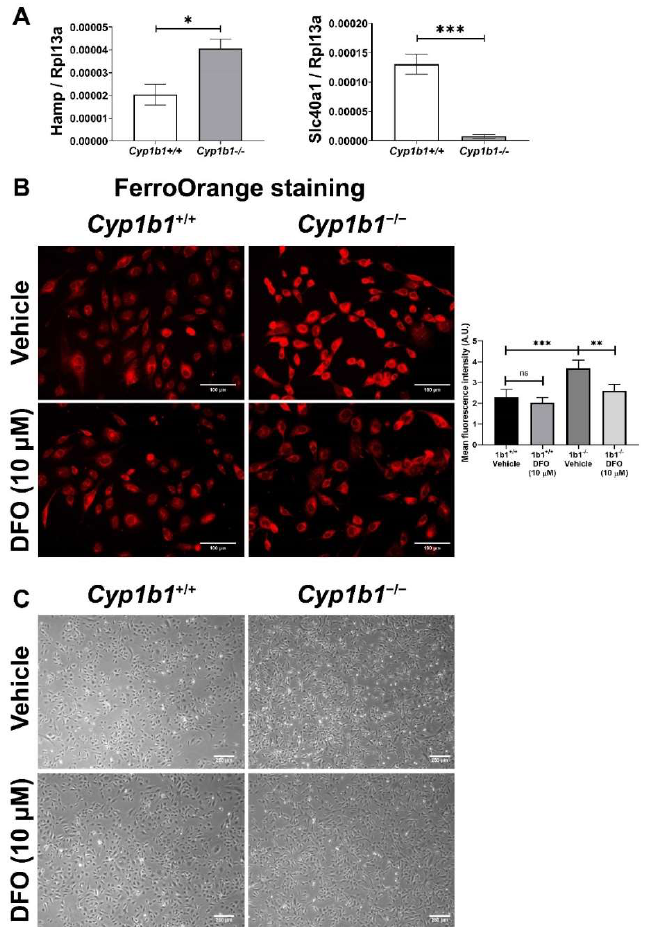
Figure 3. Intracellular iron levels are upregulated in Cyp1b1 −/− retinal ECs. ( A ) The expression levels of Hamp (gene encoding hepcidin) and Slc40a1 (gene encoding ferroportin) in Cyp1b1 +/+ and Cyp1b1 − / − retinal ECs were assessed by qPCR analysis (* p < 0.05, *** p < 0.001; n = 3). ( B ) Cyp1b1 +/+ and Cyp1b1 − / − retinal ECs were incubated with 10 µ M DFO for 48 h. Intracellular iron levels were determined by staining with FerroOrange. The cells were imaged using a fluorescence microscope (scale bars = 100 µ m), images captured in a digital format, and mean fluorescence intensities were obtained using ImageJ (** p < 0.01, *** p < 0.01; n = 5; ns: not significant). ( C ) Cyp1b1 +/+ and Cyp1b1 − / − retinal ECs were incubated with 10 µ M DFO for 24 h and the cells were photographed using a phase microscope (scale bars = 250 µ m). Please note iron chelation in Cyp1b1 − / − cells restores a more similar morphology to Cyp1b1 +/+